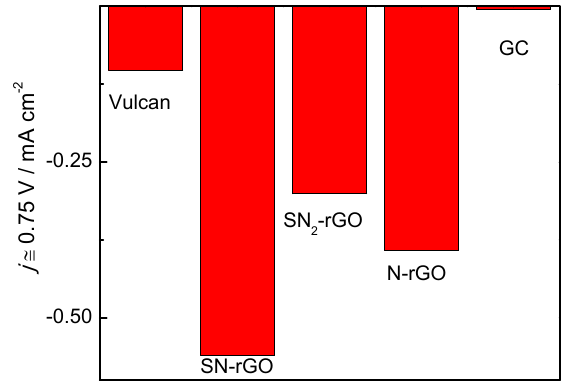
7 of 12 Figure 6. Steady ‐ state polarization curves for O 2 reduction at 1600 rpm in 0.1 M NaOH at 25 °C for all employed electrocatalysts ( top panel ); faradaic currents developed at 1.2 V at the Pt ring electrode ( middle panel ); number of electrons transferred ( n ) during the oxygen reduction reaction (ORR; bottom panel ). Sweep rate of 0.002 V s − 1 . In order to study the catalytic performance and discern the ORR pathways for the different catalysts, the rotating ring ‐ disk electrode (RRDE) technique was applied (Figure 6). The top panel shows the ORR polarization curves recorded at 0.002 V/s in 0.1 M NaOH. The great enhancement of this reaction in comparison with the current developed at lower pH values is shown (Figure 5). However, the same trend holds for the studied materials; that is, materials with a small L a and high density of L c developed a higher catalytic activity toward the ORR than GC. Interestingly, the insertion of N into the graphenic network decreased the onset potential toward the ORR, while S ‐ doping increased the electron transfer. Thus, it can be established that the catalytic activity toward the ORR at a high pH increases for doped ‐ graphene materials in the following order: SN 2 ‐ rGO < N ‐ rGO < SN ‐ rGO. This is visible in Figure 7, in which the faradaic currents acquired at 0.75 V for all the catalysts are depicted. The lowest value obtained for SN 2 ‐ rGO suggests that a compromise of the